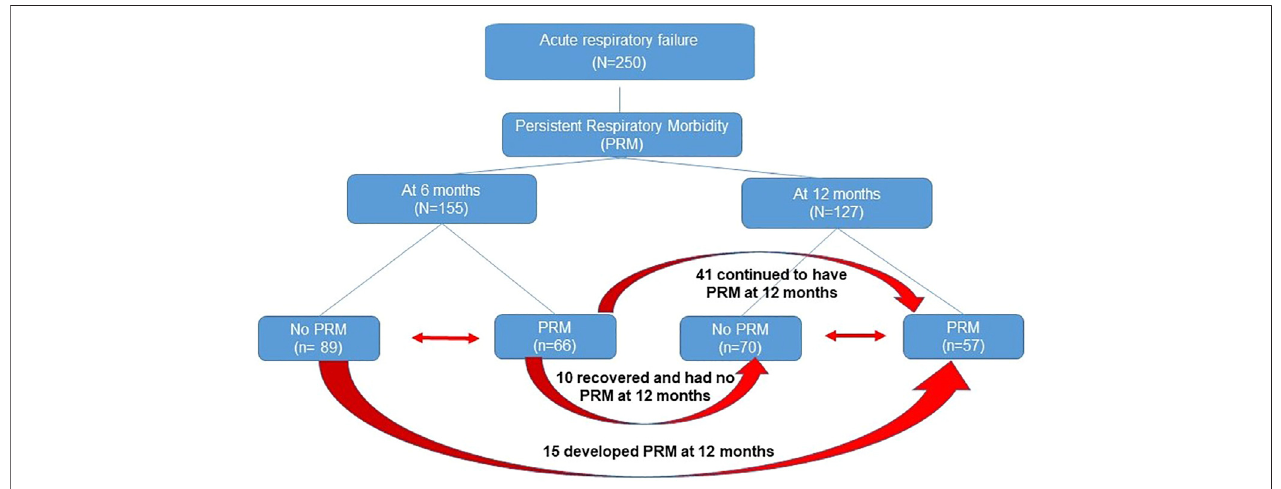
FIGURE 1 | Flow diagram of patients with persistent respiratory morbidity (PRM). Red arrow depicts transfer of patients from one group to another.